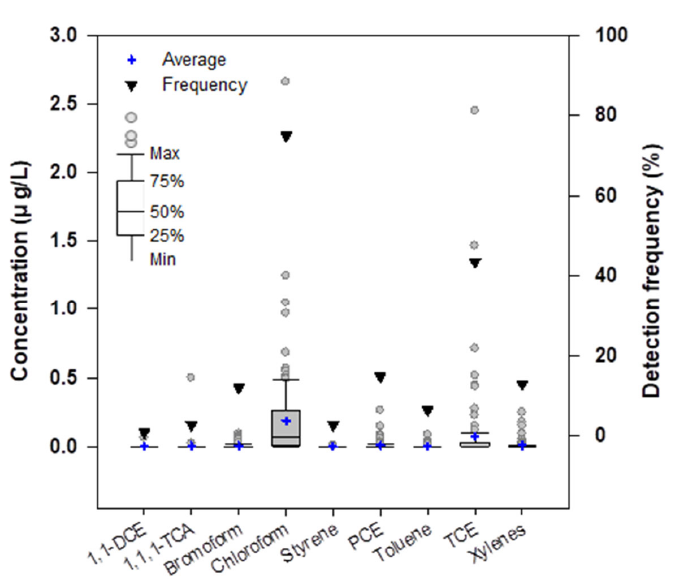
Figure 2. Distributions of VOC concentrations. Xylenes include m-, o-, and p- isomers of xylene; undetected naphthalene and vinyl chloride were excluded; sample size ( n ) = 108.